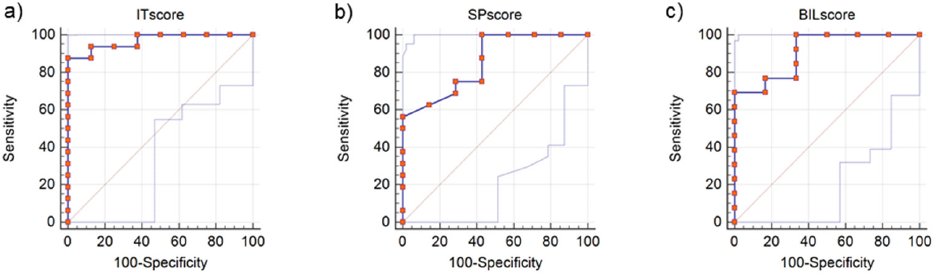
Figure 5. ( a ) ROC curve for the Italian overall score (distinction between presence ( n = 16) vs. absence of pathological scores or DLD diagnosis, n = 8), AUC = 0.969; ( b ) ROC curve for the Spanish overall score for the presence of DLD and DLD risk (distinction between presence ( n = 16) vs. absence of pathological scores or DLD diagnosis, n = 7), AUC = 0.857; ( c ) ROC curve for the bilingual overall score (distinction between presence ( n = 13) vs. absence of pathological scores or DLD diagnosis, n = 6), AUC = 0.905.